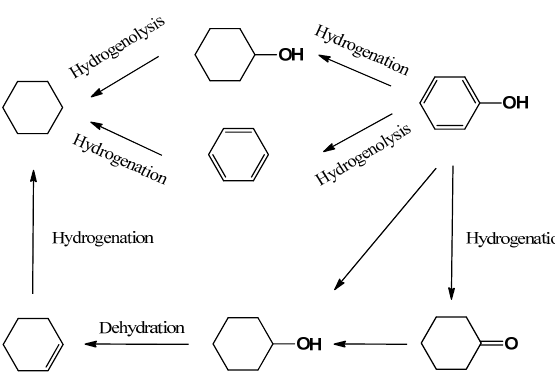
hydrodeoxygenation over traditional catalyst; (bottom) tandem hydrogenation-dehydration over multifunctional systems.